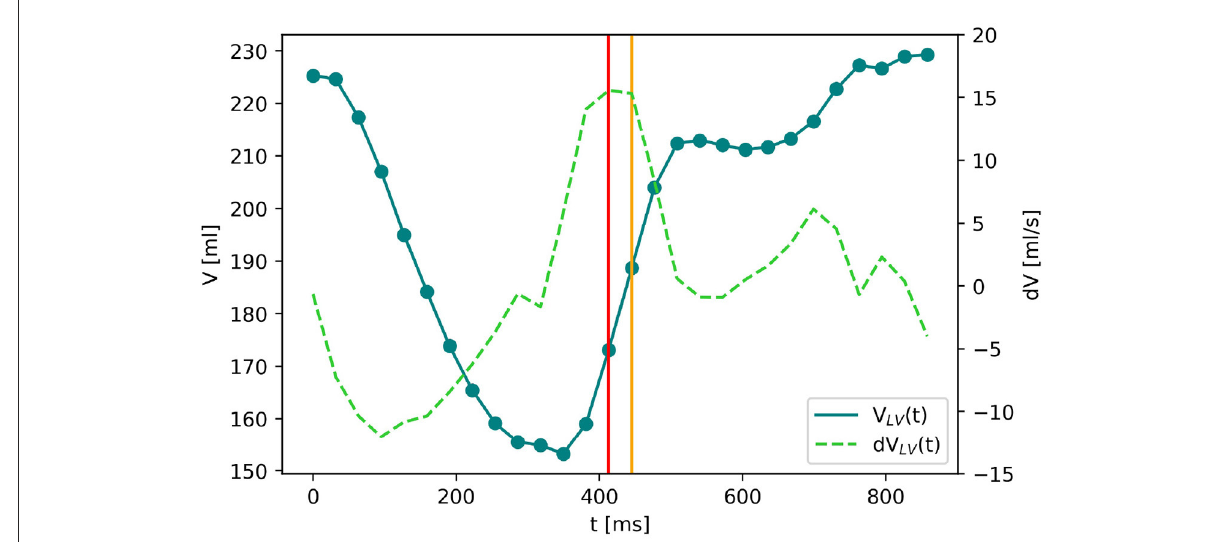
FIGURE3 The blue solid line shows the volume curve V LV ( t ) of the left ventricle of Patient 2 over the time of one heartbeat. The dots are the time frames of echocardiographic imaging. dV LV ( t ) (green dashed line) denotes the LV volume change between two subsequent time frames. The biggest positive volume change (marked by the red vertical line) indicates the E-wave which is the moment of maximal blood flow through the mitral valve during diastole. The LV segmentations at this and the following time point (yellow vertical line) are chosen to create the surface distance map for the boundary condition of the computational fluid dynamics (CFD)